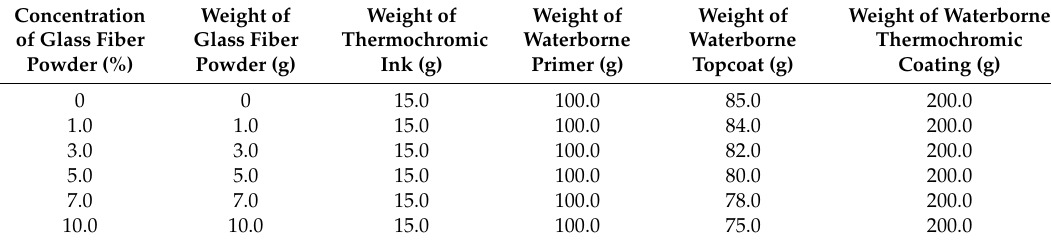
Table 1. Ingredients of the waterborne coating with thermochromic ink and glass fiber